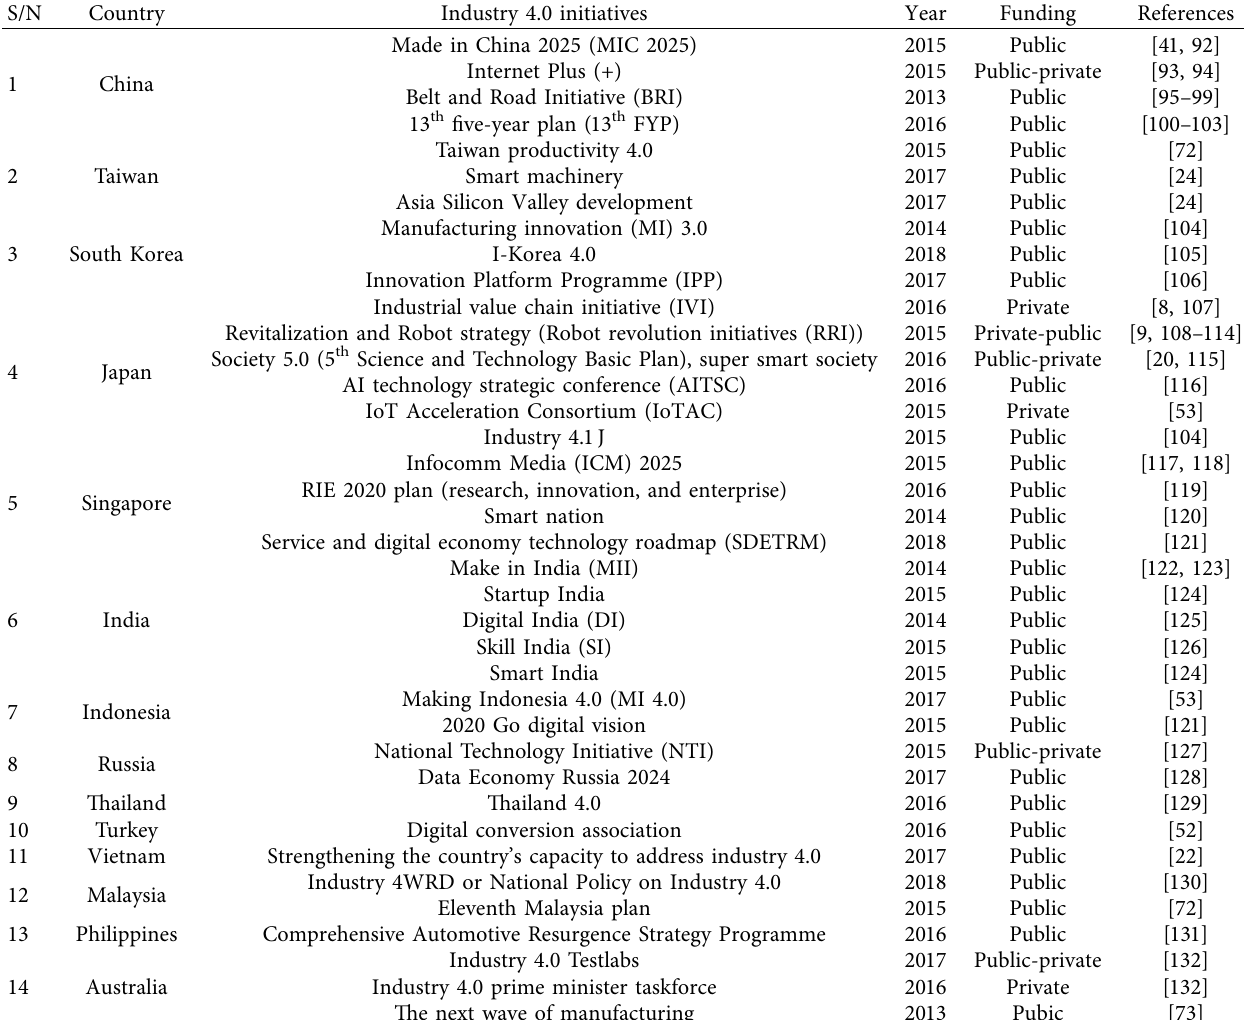
Table 4: Industry 4.0 initiatives launched in Asia and Oceania.